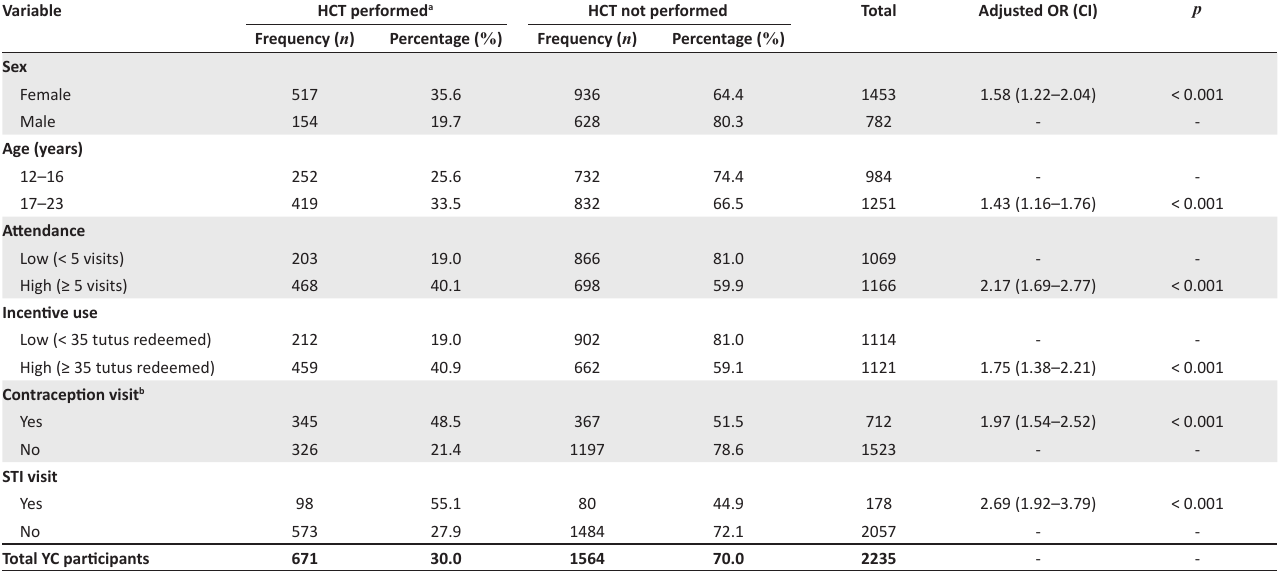
TABLE 4: Multivariable logistic regression analysis on the effect of independent variables on HIV counselling and testing (exposed to HIV counselling and testing) versus not HIV testing (unexposed to HIV counselling and testing) at the Desmond Tutu HIV Foundation Youth Centre in